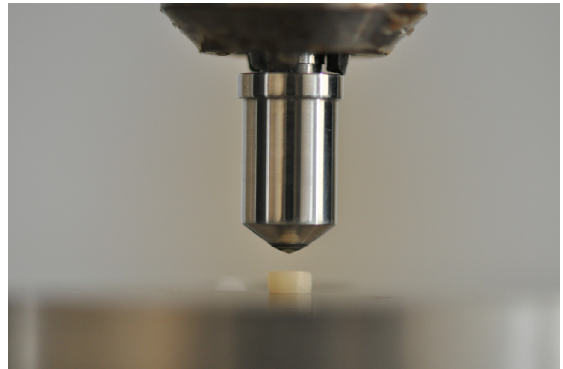
Figure 6. Sample subjected to Vickers indentation.